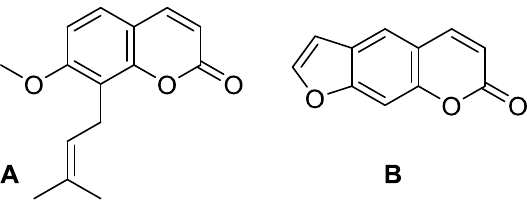
Figure 14. Chemical structured of osthole ( A ) and psoralen ( B ).